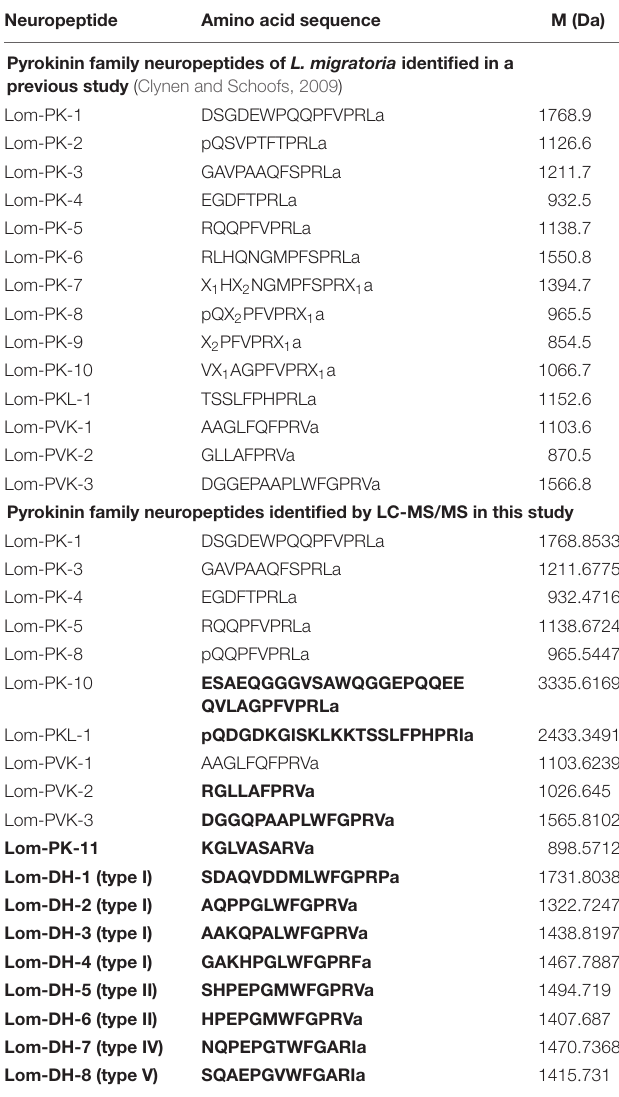
TABLE 2 | Pyrokinin family neuropeptides identified in Locusta migratoria L. Neuropeptide Amino acid